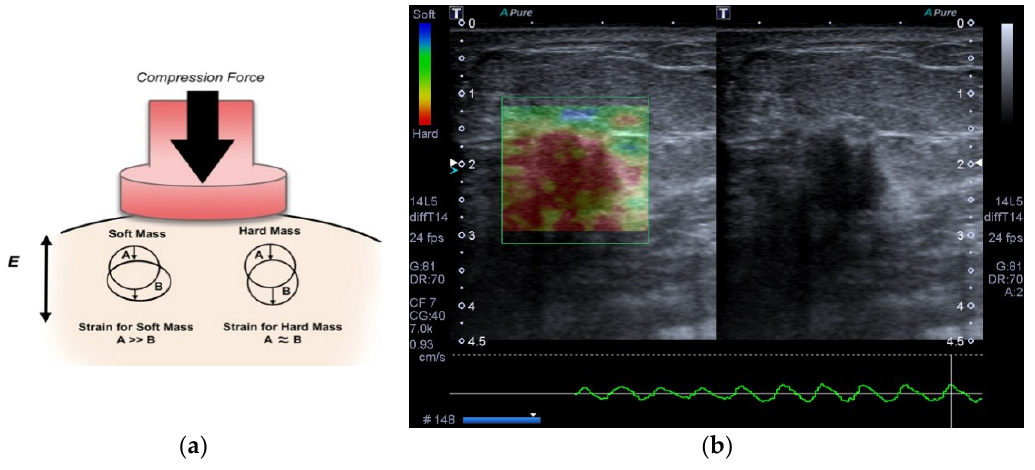
Figure 1. Strain elastography measures tissue displacement as a consequence of an applied initial compression. ( a ) Behavior of the soft and hard tissue after a compressive force. The displacement of the first is larger in soft tissue than hard tissue. ( b ) Image of invasive ductal carcinoma in a 56-year-old woman with strain elastography on left and B-mode ultrasound on right.